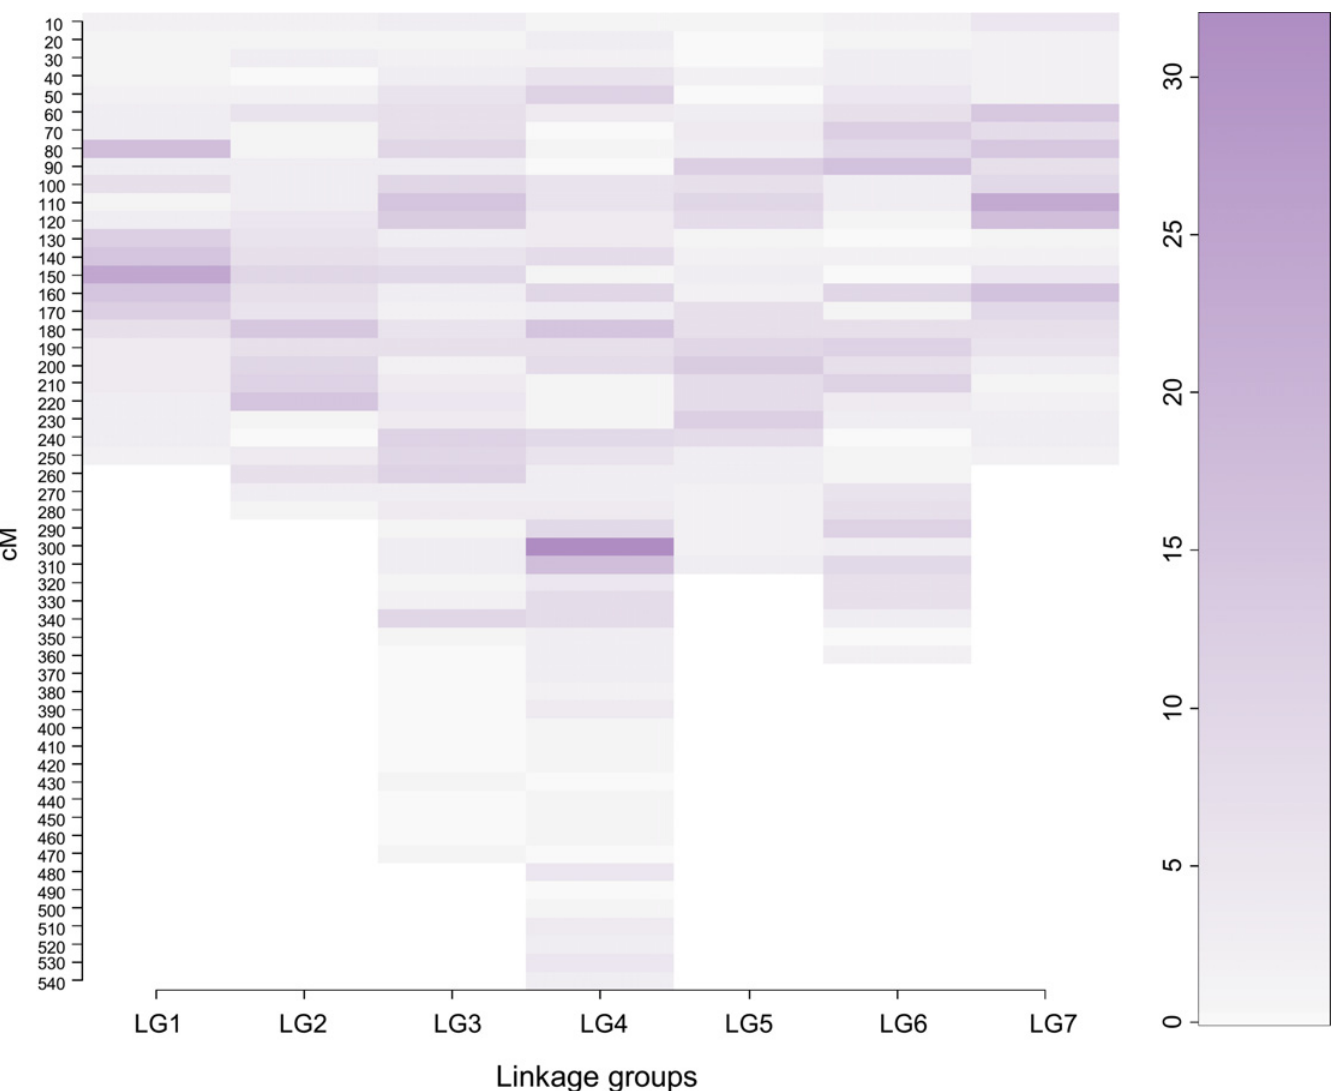
Fig 2. Marker density in the candidate gene-based genetic map. The linkage groups are presented on the x axis. The y axis corresponds to the most plausible positions in cM on the final candidate gene based genetic map. The color scale illustrates the number of candidate genes mapped in intervals of 10